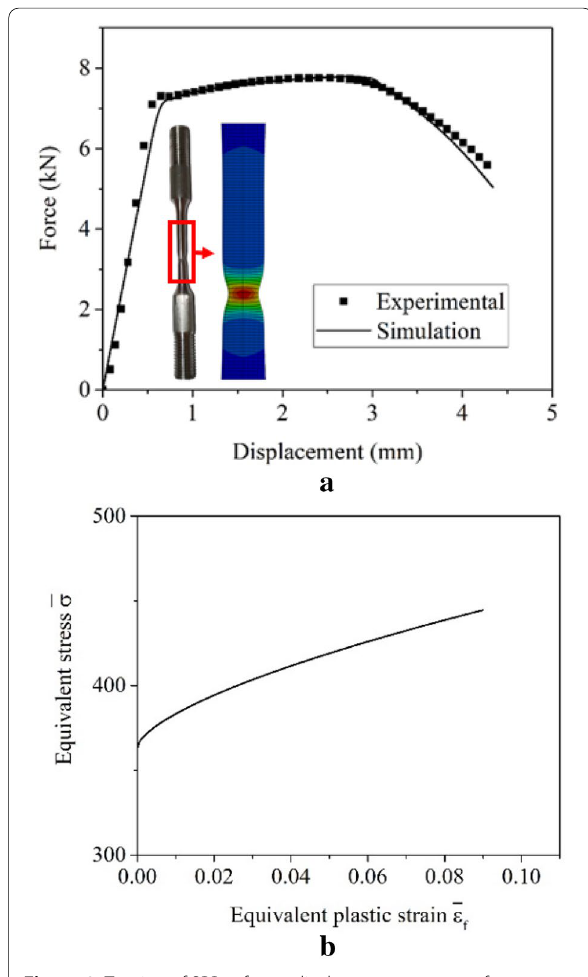
Figure 8 Tension of SRB: a force–displacement response from experiments and simulation; b equivalent stress–equivalent plastic strain curve of AA6063